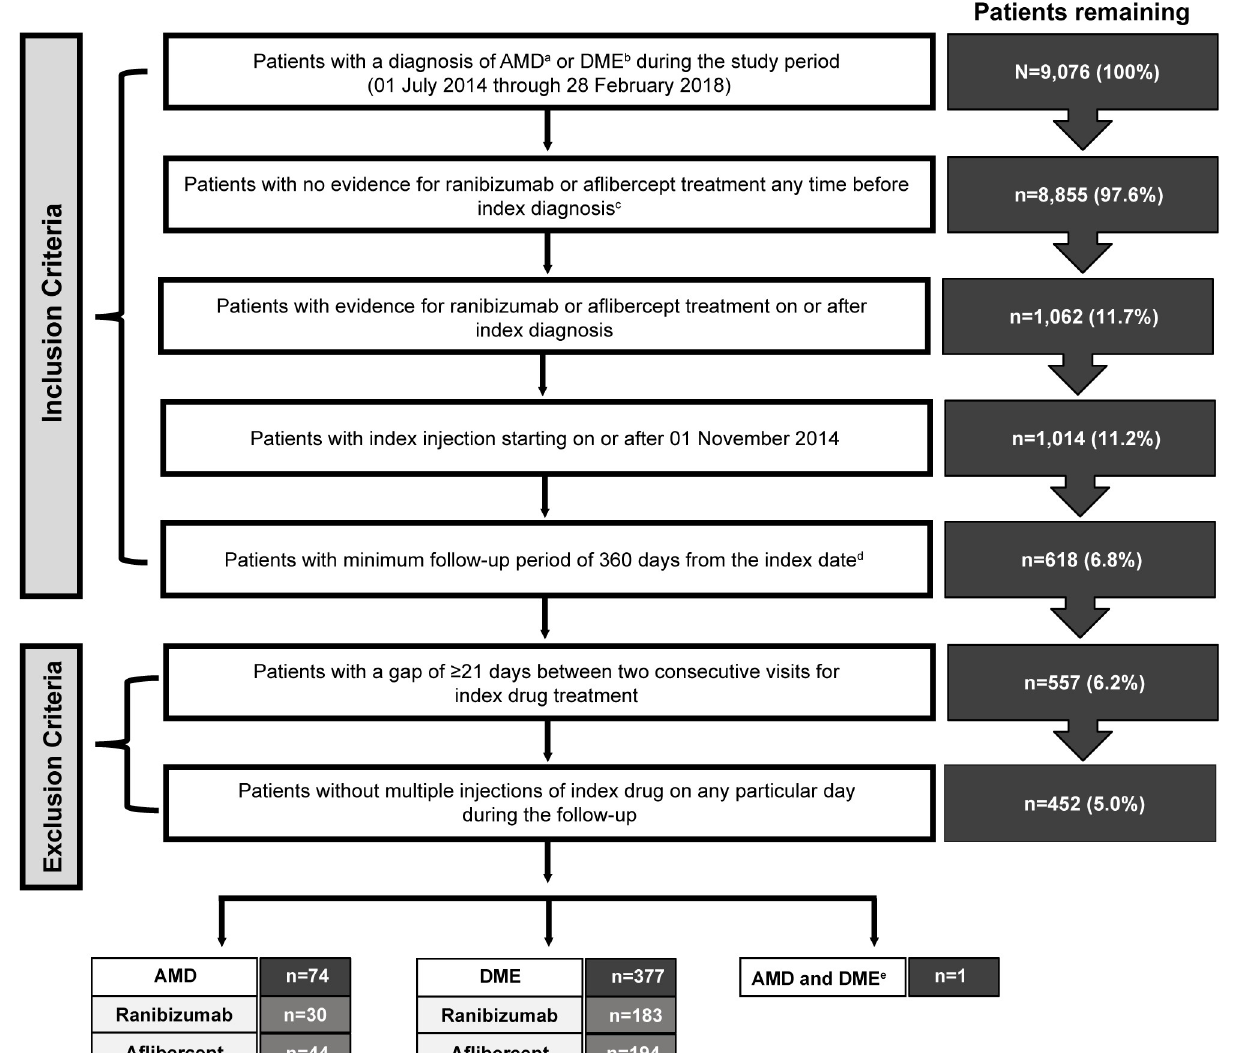
Fig 1. Patient selection criteria and attrition of study population. a ICD-10 diagnosis codes for AMD: H35.32. b ICD-10 diagnosis codes for DME: E11.311/21/31/41/51, E13.351, E08.341, E08.311. c Index diagnosis: The date of first diagnosis of AMD or DME. d Index date: The date of first treatment with ranibizumab or aflibercept. e One patient was diagnosed with both AMD and DME and was treated with aflibercept. AMD, age-related macular degeneration; DME; diabetic macular edema; ICD-10, International Classification of Diseases, 10th Revision; N, total number of patients; n, number of